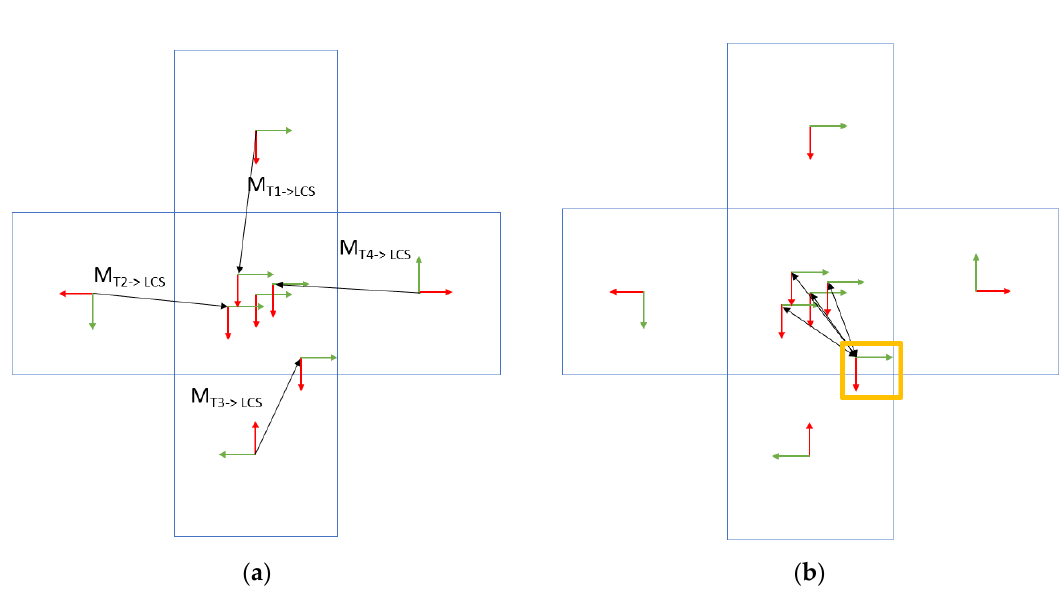
Figure 11. An illustration (not to scale) to describe the error measurements and correction. ( a ) transforms the tag poses from their coordinate frame to the center tag frame. ( b ) shows the error in deviation observed during the experiment, the detected pose marked with the yellow box has the highest deviation. Algorithm 2 Calculating the Error in the Net Pose Estimation of the 3D Grid Board Detect tvecs of Tags